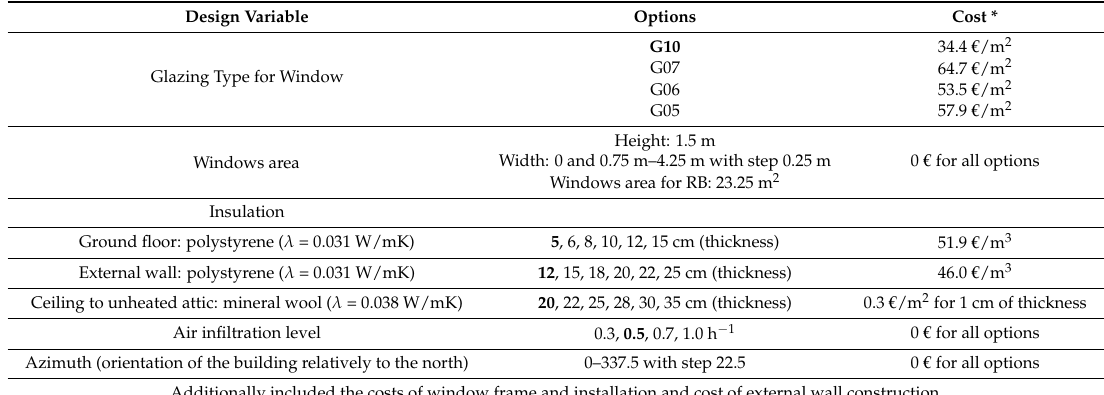
Table 4. Cost data for design variables and options used for the optimization